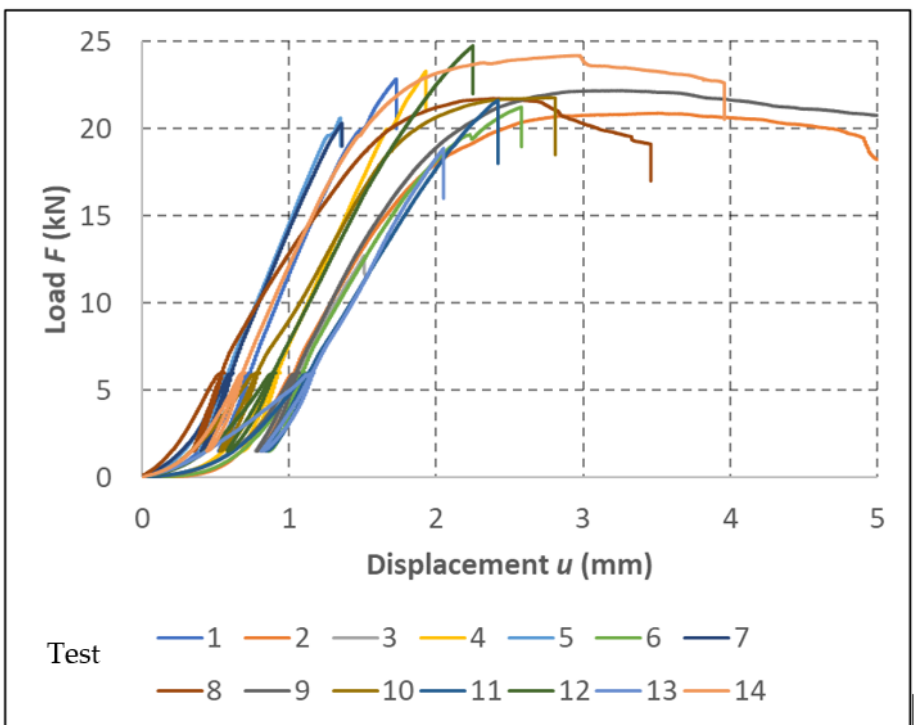
Figure 5. Results of laboratory tests for the determination of hole wall strength and compressibility characteristics for dowel fasteners.